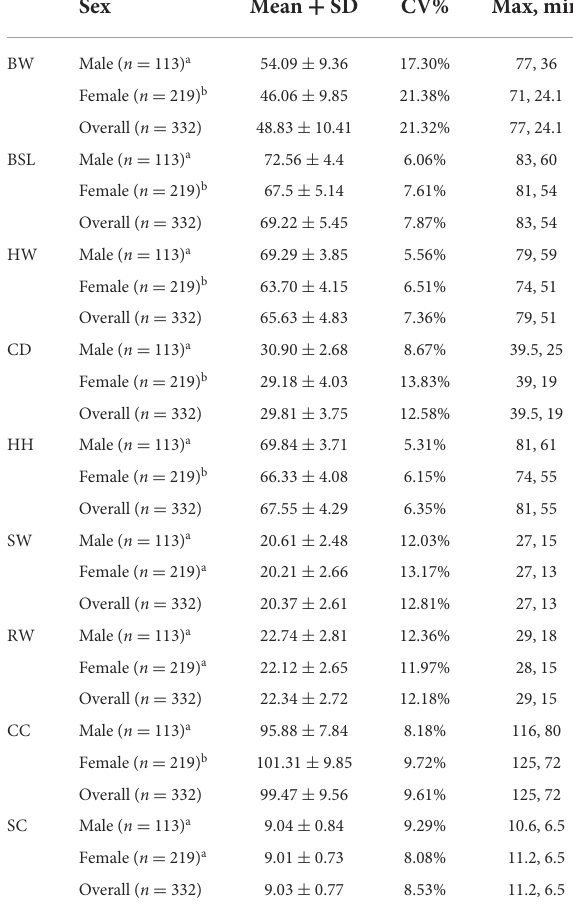
TABLE 1 Basic data